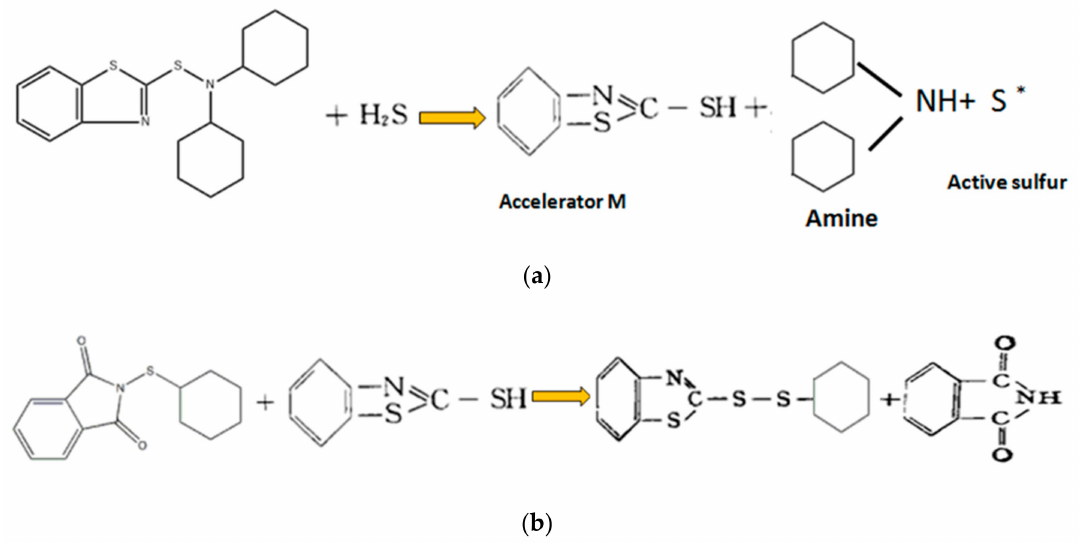
Figure 2. Decomposition mechanism of CTP and disulfonic acid amine accelerants in delayed formulation: ( a ) Reaction of sulfonic amine accelerator DZ during vulcanization; ( b ) Decomposition mechanism of CTP and disulfonic acid amine accelerants in delayed